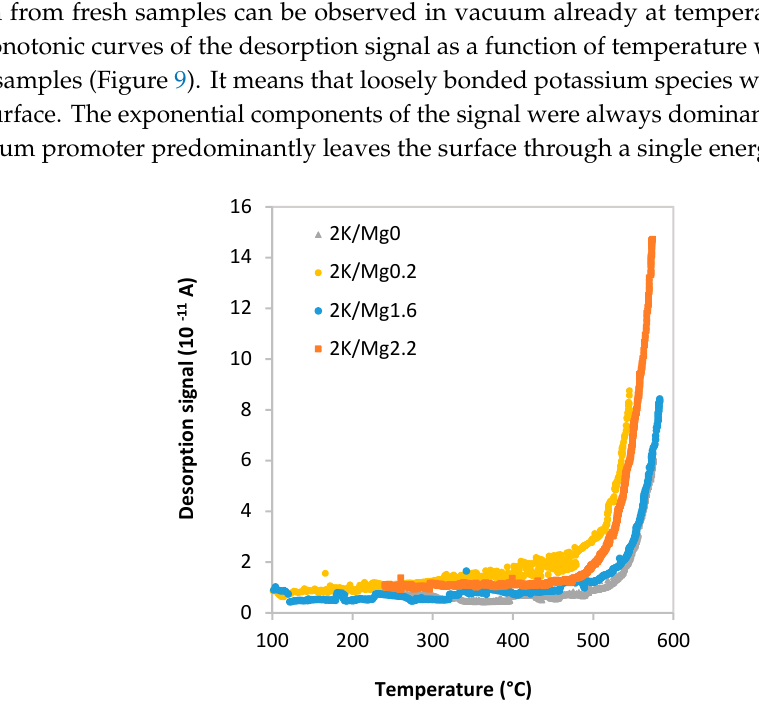
Table 3. Activation energies of K desorption for selected samples.